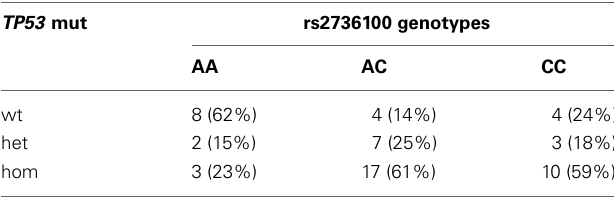
Table 1 | Association between rs2736100 and TP53 mutations. TP53